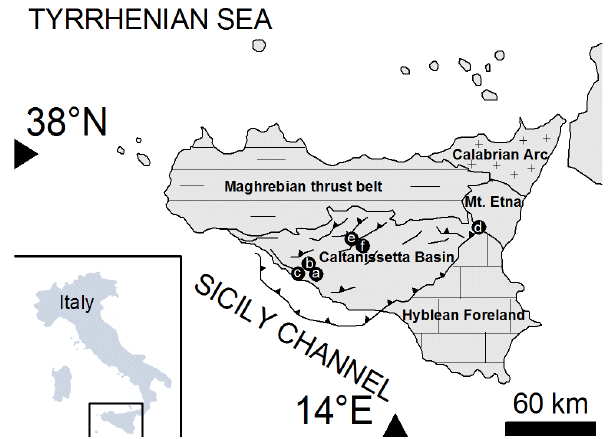
Fig. 1. Structural setting of Sicily with location of onshore mud vol- canoes. (a) Maccalube at Aragona; (b) Fuoco di Censo at Bivona; (c) Bissana at Cattolica Eraclea; (d) Salinelle at Patern ` o; (e) Maria- nopoli; (f) Santa